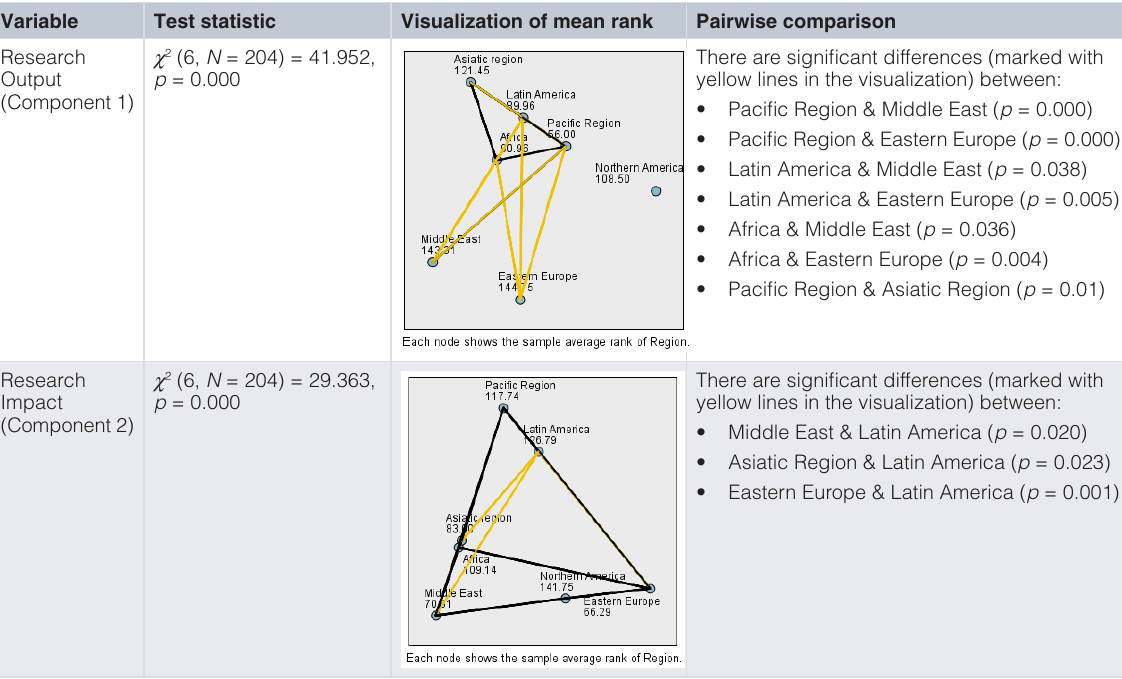
Table 6. Comparison of research performance and impact between regions.